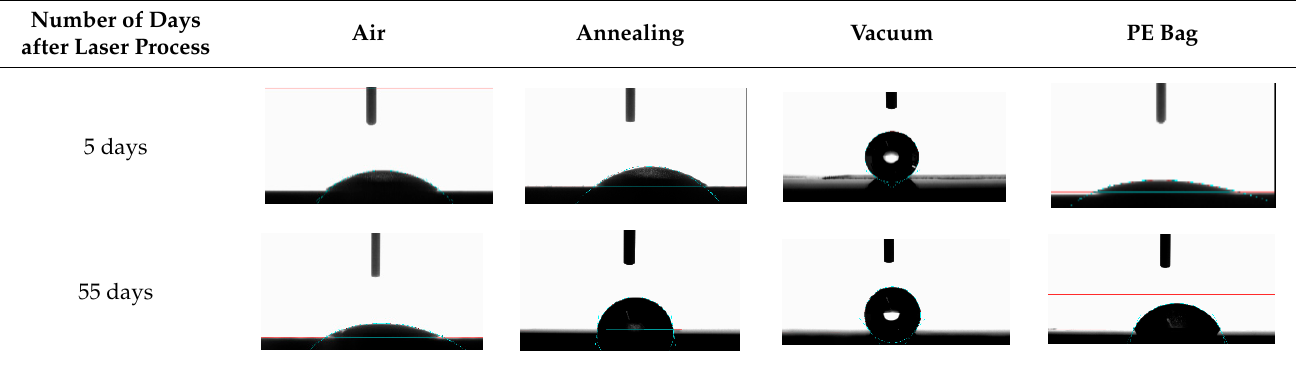
Table 7. Comparison of a droplet images for structure C after 5 and 55 days. Number of Days after Laser